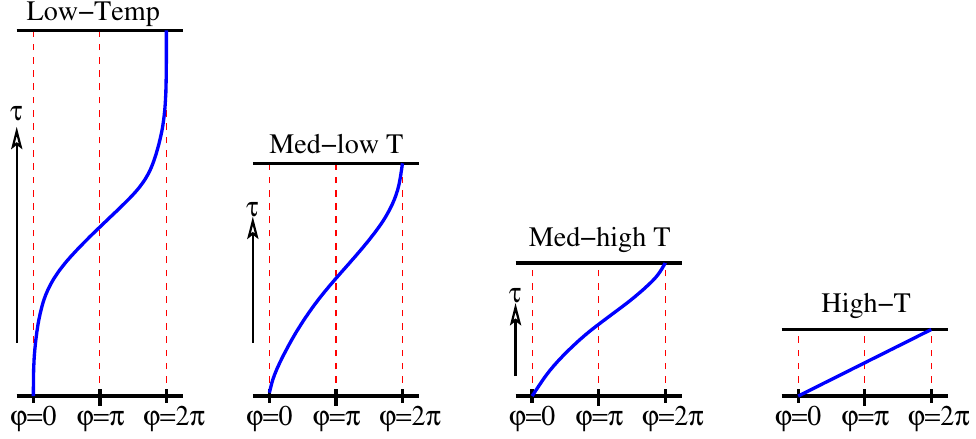
Figure 1 . Instantons as a function of temperature. At low temperatures, ϕ transitions from 0 to 2 π along a smooth characteristic curve. With increasing T , as the range of t -periodicity